Question: Briefly state, in one sentence, what is plotted here.
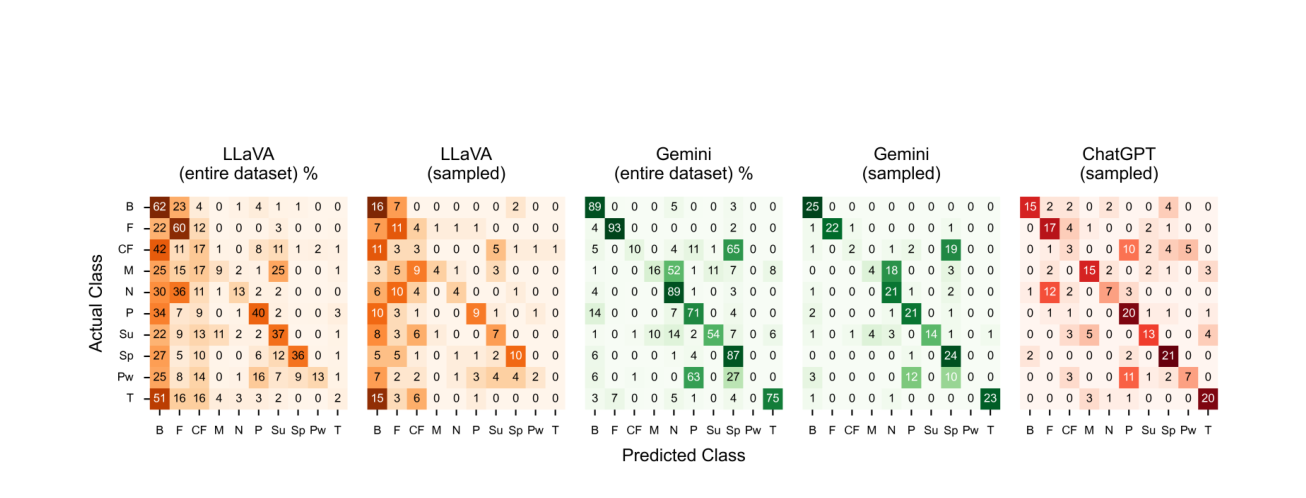
Answer: Confusion matrices for the classification of ten categories in the NFFA dataset by (a) LLaVA on the entire dataset (numbers denote percentages with respect to the number of actual samples present in the respective classes), (b) LLaVA on 25 images per class of the NFFA-RS, (c) Gemini on the entire dataset (numbers denote percentages as in (a)), (d) Gemini on 25 images per class of the NFFA-RS, and (e) ChatGPT on 25 images per class of the NFFA-RS. Class names have been abbreviated as noted in Table I.